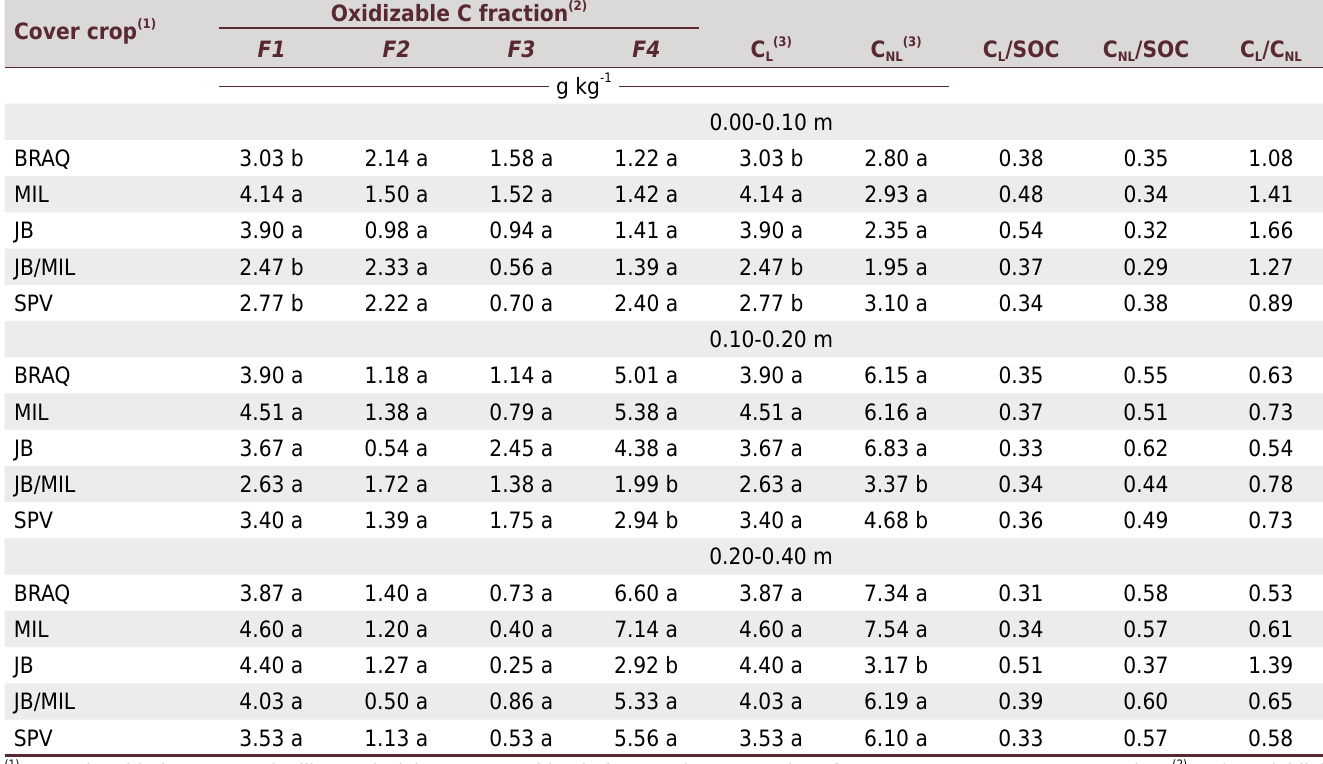
(1) BRAQ: brachiaria; MIL: pearl millet; JB: jack bean; JB/MIL: blend of JB+MIL in a proportion of 50 %; SPV: spontaneous vegetation. (2) F1 (very labile): oxidizible organic C under 3 mol L -1 H 2 SO 4 ; F2 (labile): difference in oxidizible organic C extracted between 6 and 3 mol L -1 H 2 SO 4 ; F3 (less labile): difference in oxidizible organic C extracted between 9 and 6 mol L -1 H 2 SO 4 ; F4 (recalcitrant): difference between total SOC and oxidizible organic C under 9 mol L -1 H 2 SO 4 . (3) C L (Labile C): comprise C contents extracted in F1 ; C NL (non-labile C): comprise C contents extracted in F3+F4 . Means followed by the same lower-case letters in a column, within each soil layer, do not differ significantly by the Scott-Knott test